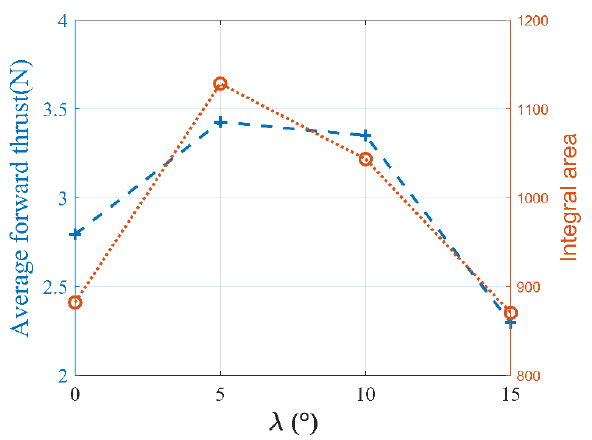
Figure 29. Comparison results of simulation experiment and tank experiment (K = 8).